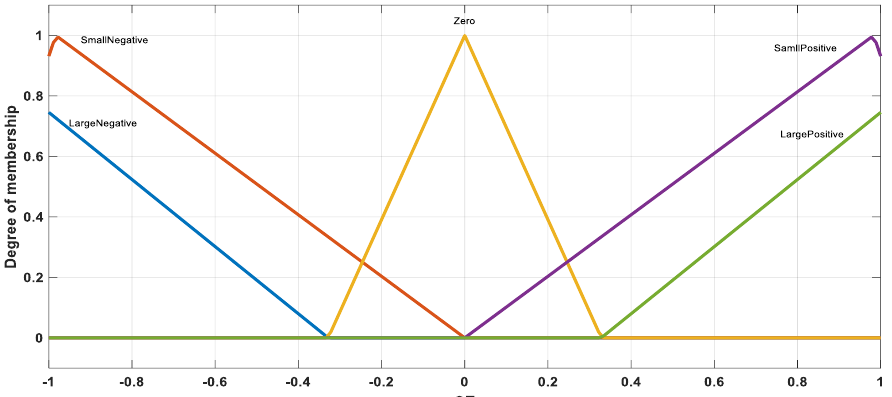
Figure 6. Ideal triangular input error membership functions.